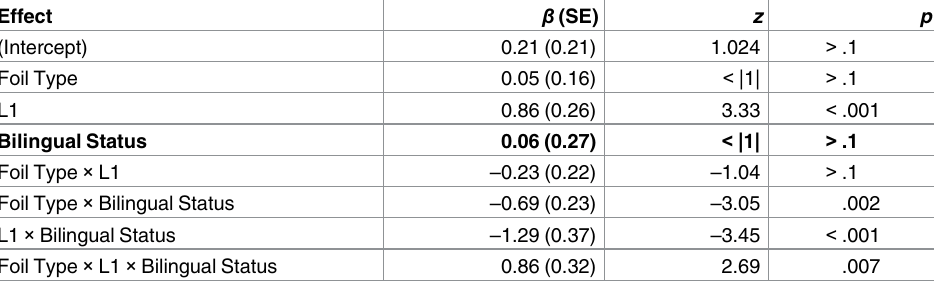
Table 6. Logit mixed-effects model with best fit on listeners’ accuracyin condition with F0 cues (with monolingual English listeners’ performance on part-word foils as baseline) a